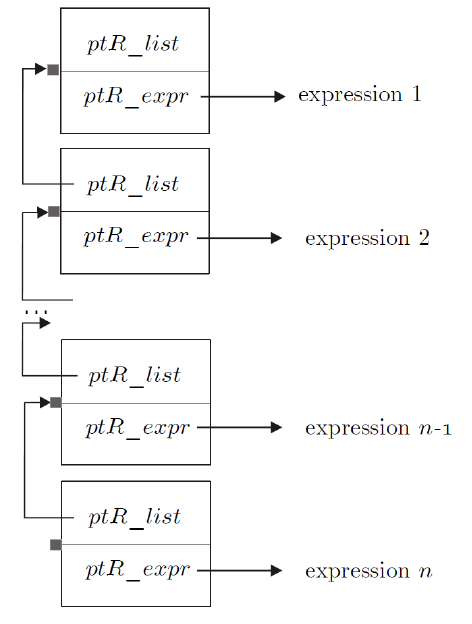
Figure 6. Dynamic linked list of expressions.